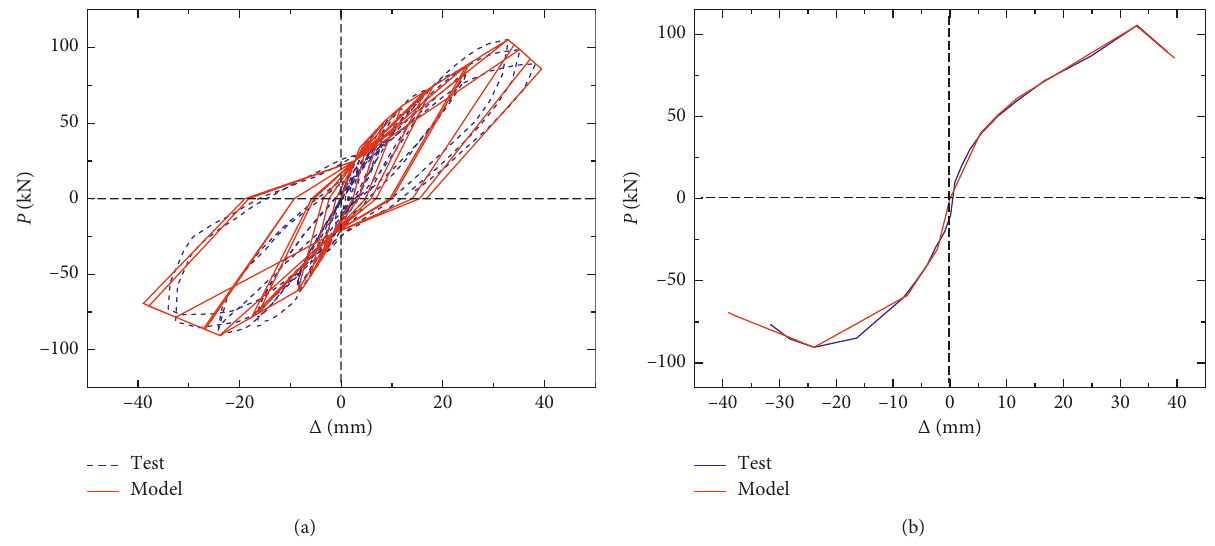
Figure 12: Comparison of the restoring force model and test results of specimen S1: (a) hysteretic curves; (b) backbones.